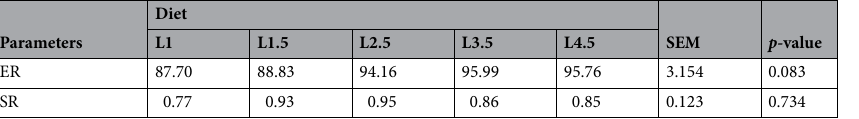
Table 4. Effect of the diet on the emergence rate and sex ratio. L1 EE 1% diet, L1.5 EE 1.5% diet, L2.5 EE 2.5% diet, L3.5 EE 3.5% diet, L4.5 EE 4.5% diet, ER emergence rate, SR sex ratio, SEM standard error of the mean.